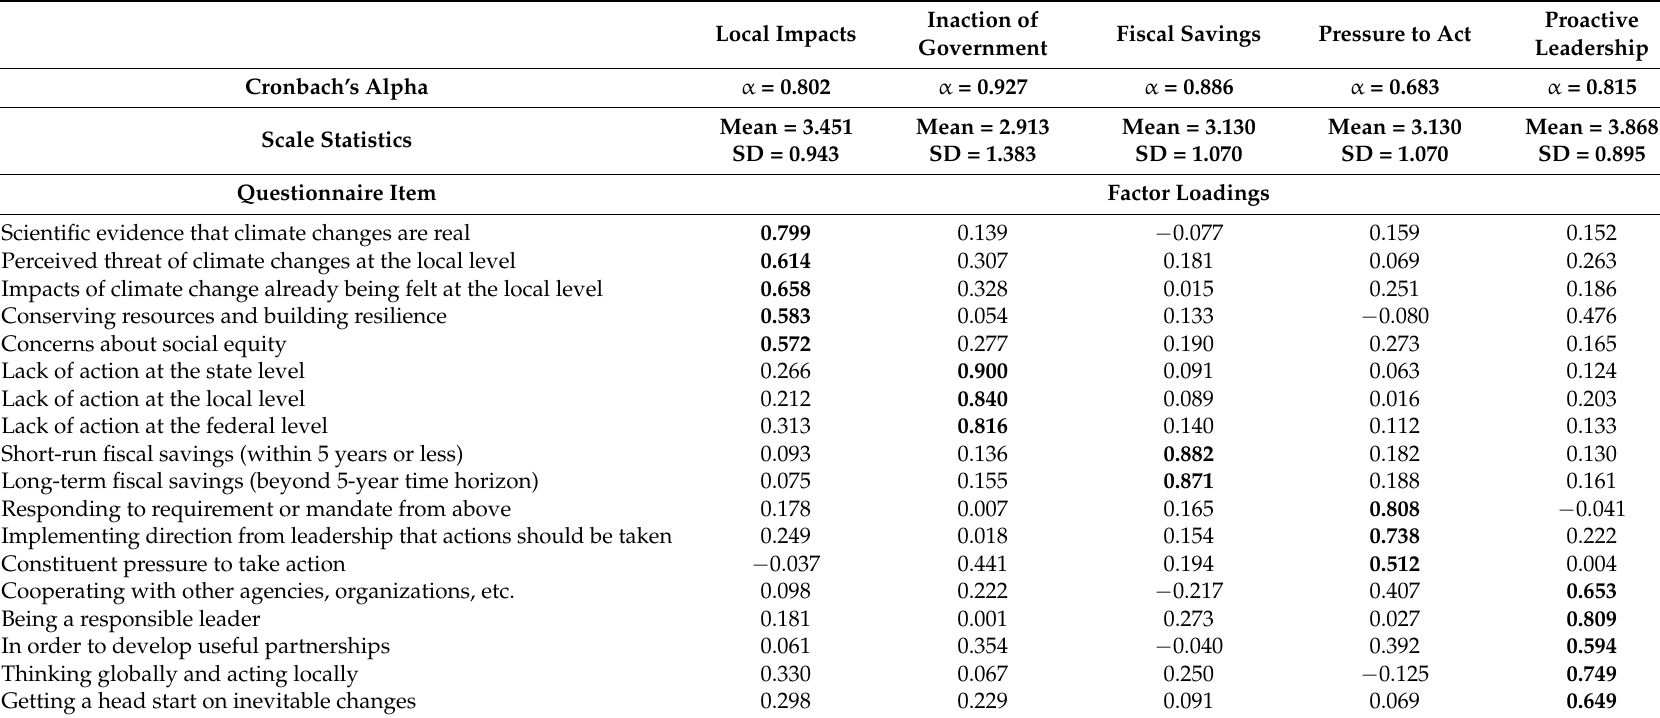
Table 1. Factor analysis 1 results for climate action “Influencing Factors” 1 including factor loadings, Cronbach’s alpha, and scale mean and standard deviation